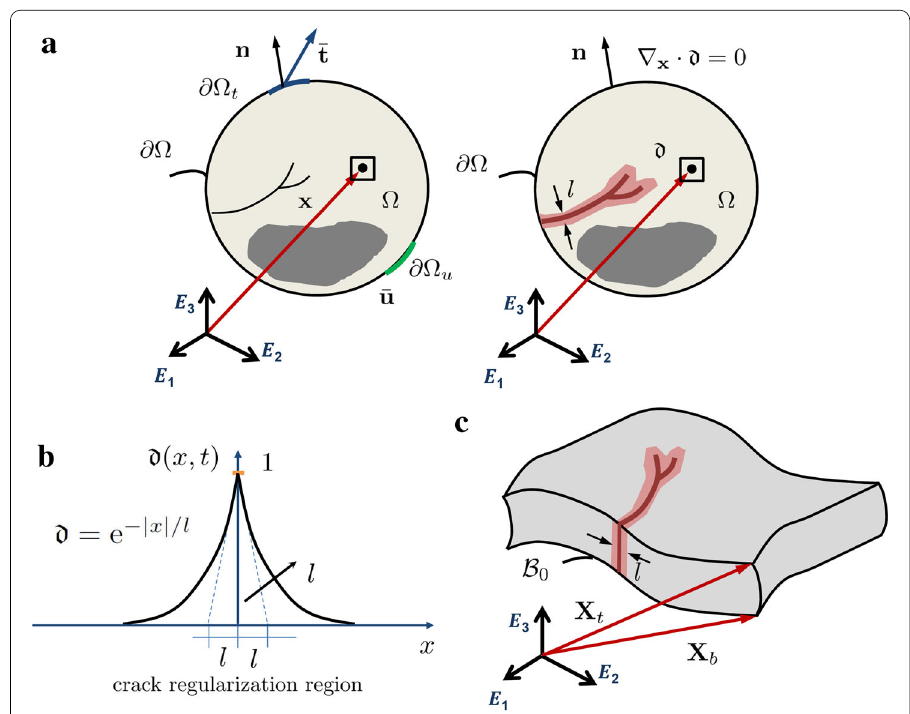
Fig. 1 a Comparison between the discrete discontinuity of the LEFM theory (left) with the smeared discontinuity of the PF model (right); b 1D approximation function which smear out the discontinuity, the damage d follows the exponential based function d = e −| x | / l . c Phase field approach for thin-walled structures adopting the solid shell